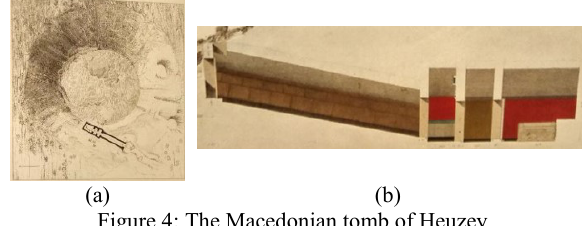
Figure 4: The Macedonian tomb of